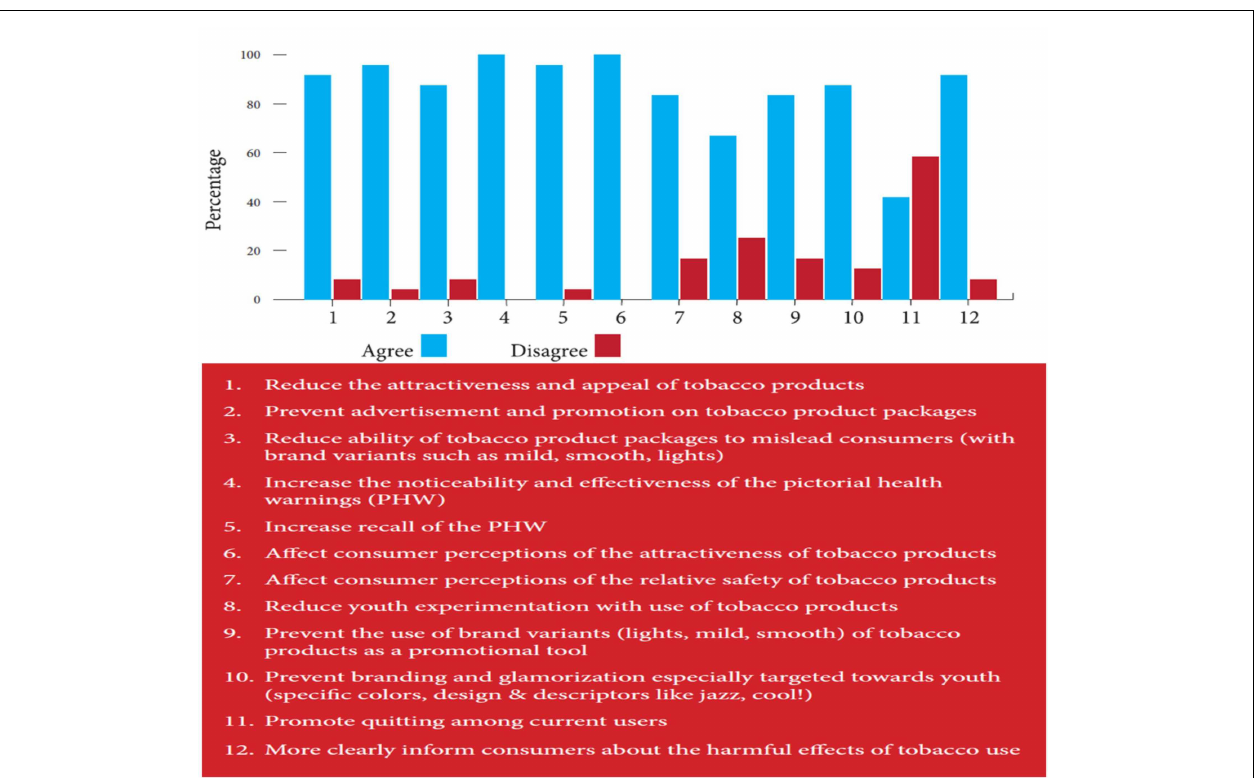
FIGURE 2 | Perceptions of key stakeholders about the impact of plain packaging